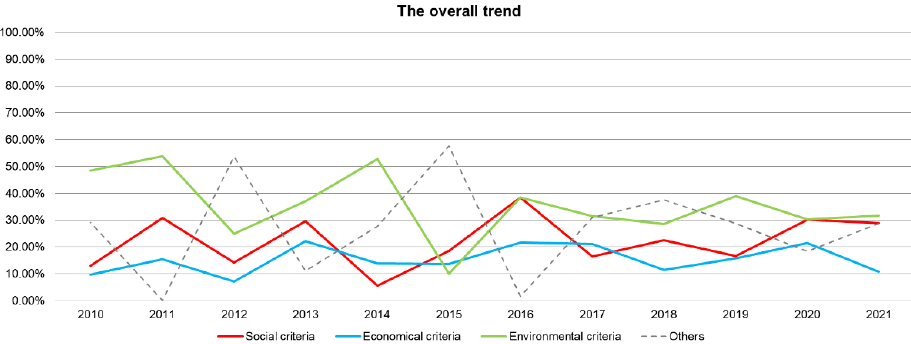
Figure 9. The annual distribution of the proportion of criteria categories.